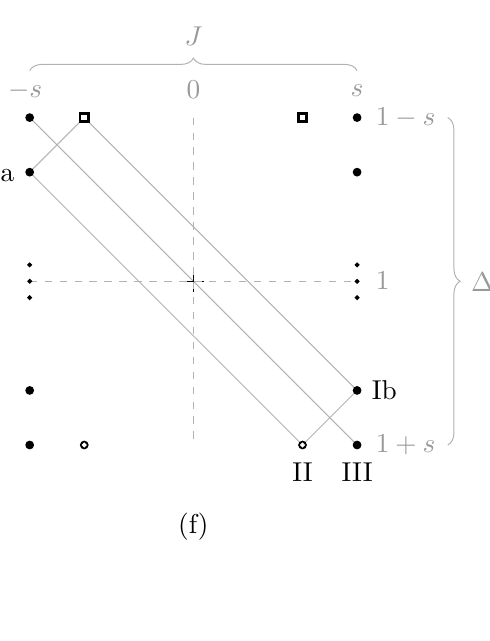
Figure 9. Celestial diamonds demonstrating non- trivial primary descendants. Solid dots correspond to radiative primaries while open dots and squares correspond to generalized primaries. Skipped nodes correspond to non-primary descendants. Subfigures (a)-(e) cover the s = 0 through s = 2 examples in half-integer steps. In each case the SL(2, C ) spin J is bounded by | J | ≤ s . Radiative states lie at J = ± s